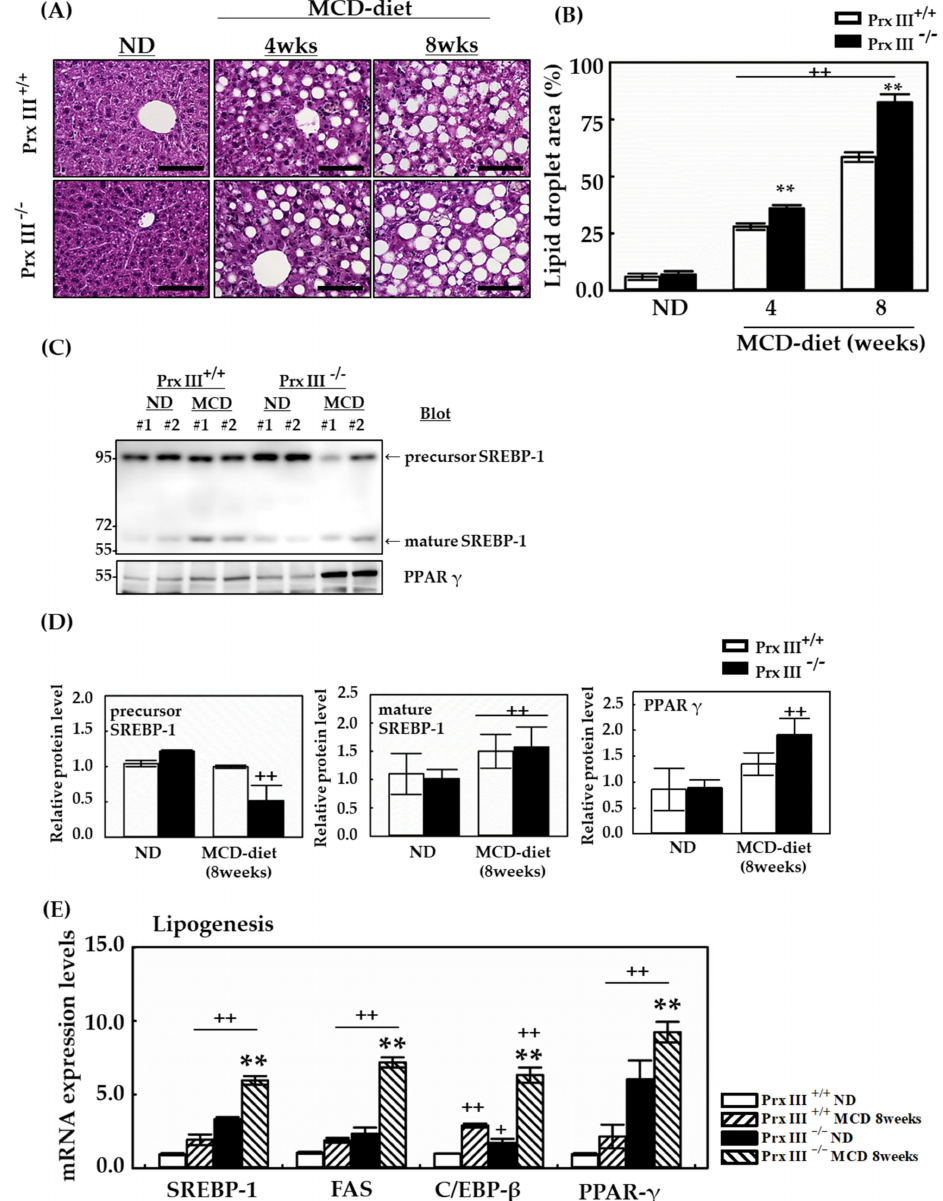
Figure 3. Effects of Prx III deficiency on liver morphology and hepatic lipogenesis in the MCD diet revealed by H&E staining. Prx III +/+ and -/- mice were fed the ND or MCD diet for 4 and 8 weeks. Mice were sacrificed for analyses at both times. The liver was fixed with 4% formaldehyde solution in phosphate-buffered saline at 4 ◦ C overnight and embedded in paraffin. ( A , B ) Liver sections (4 µ m thick) were stained by H&E and stain deposition was quantified using. NIS-Elements AR 3.1 software. The scale bars indicate 100 µ m at original magnifications of 400 × . In addition, livers obtained at 8 weeks from mice fed the MCD diet were analyzed by Western blotting. For statistical significance, five liver extracts of the same part in each individual were used for each group. ( C , D ) Expression levels of SREBP-1 and PPAR γ in the liver of mice fed the MCD diet. Protein expression levels were normalized against GAPDH protein and are expressed as mean ± SD. Real-time PCR was performed to assess mRNA levels of lipogenesis-related genes in mice fed the MCD diet for 8 weeks. mRNA isolated from liver samples using TRIzol reagent was subjected to RT-PCR and quantitative